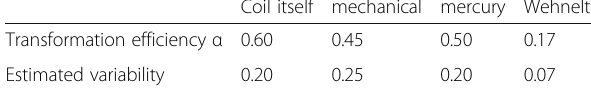
Table 2 Electrical transformation efficiency ( α ) of inductor with various interrupters (Additional file 1: ES VII) Coil itself mechanical mercury Wehnelt Transformation efficiency α